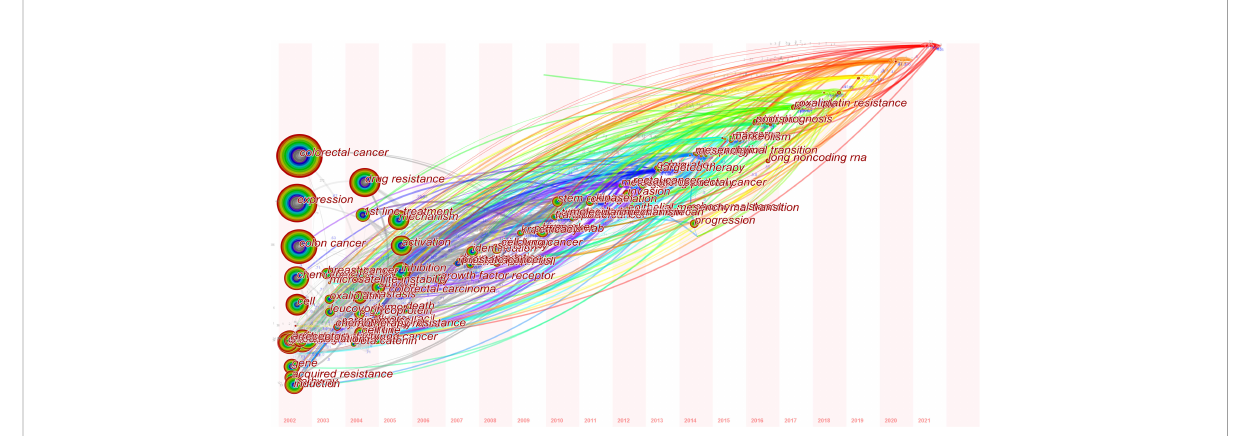
FIGURE 10 Time zone view of keywords (co-occurrence rate ≥ 40) for colorectal cancer drug resistance. The position of the circles on the horizontal axis represents the year in which the keyword fi rst appeared. The size of the circle re fl ects the frequency of co-occurrence, and the lines between the circles represent the co-occurrence of two keywords.